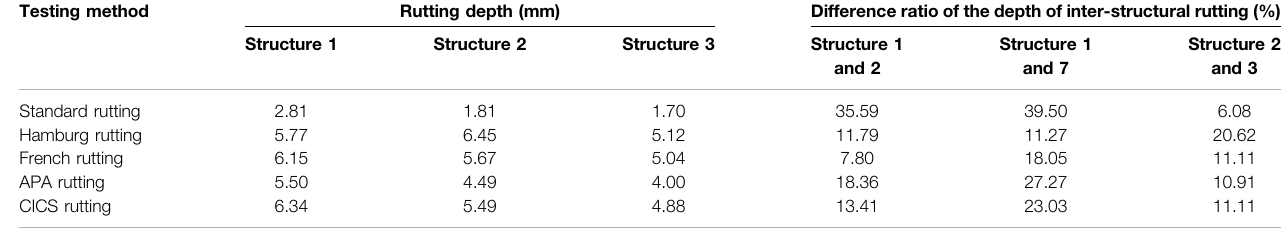
TABLE 4 | Difference ratio between rutting test depth and inter-structural rutting.